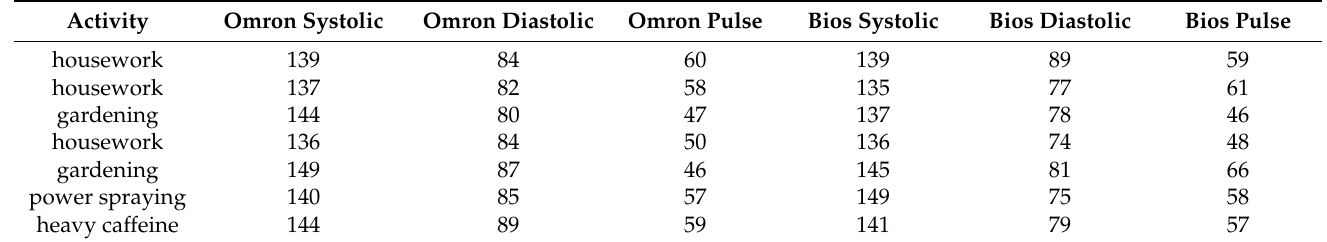
Table 1. Blood pressure (mmHg) and pulse measurements (BPM) taken at interrupted times during daily activities using both the Omron and Bios devices. Patient stopped doing the task and sat down for 30 s prior to measurements.